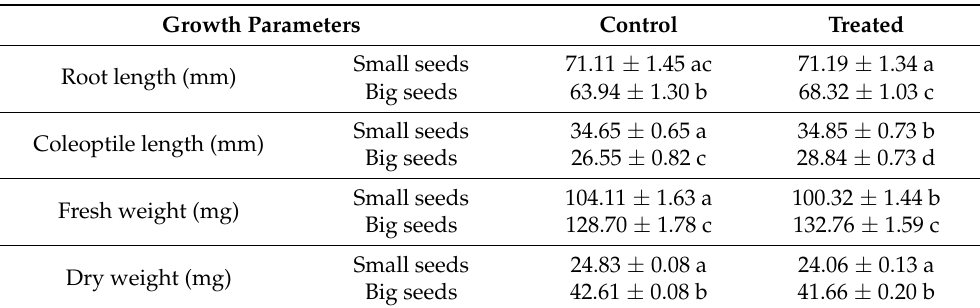
Table 5. Growth parameters of 3-day-old seedlings growing in darkness from small and big seeds of winter wheat, in controls and EMF treatment conditions.